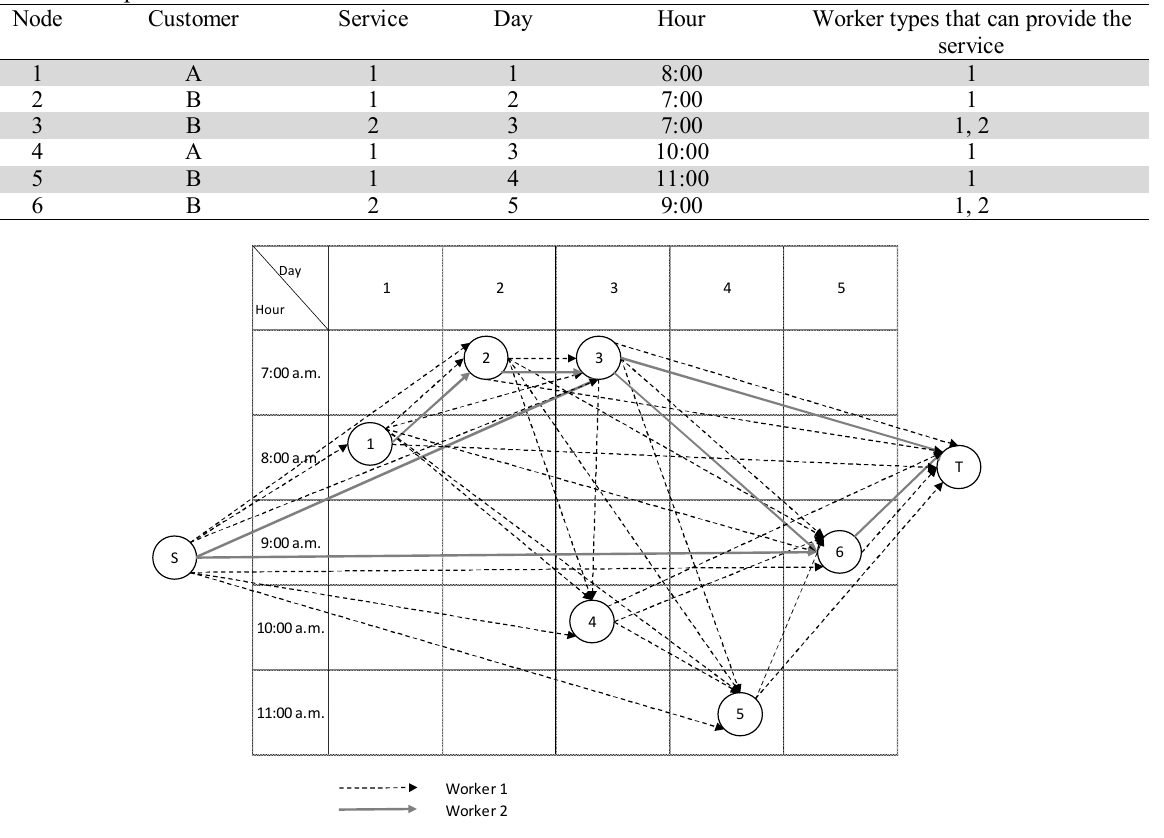
Fig. 1. Resulting graph for the